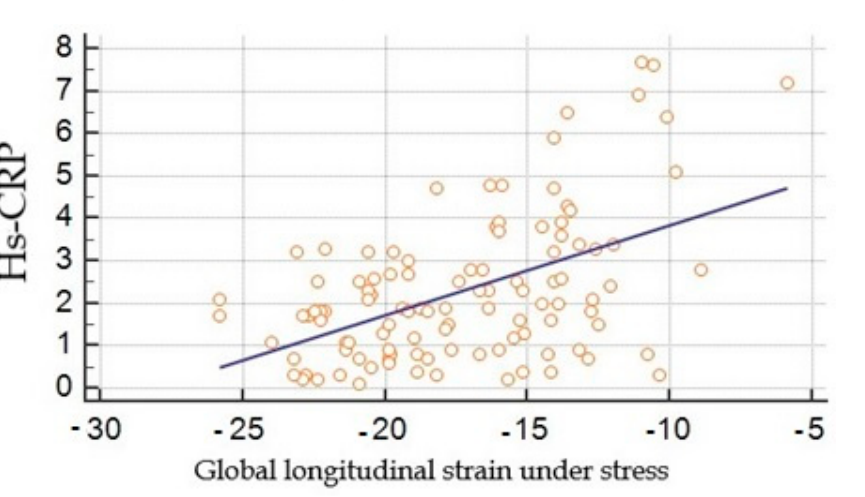
Figure 7. Correlation between global longitudinal strain under stress obtained by speckle tracking (in %) and high sensitivity C-reactive protein (in mg/L).